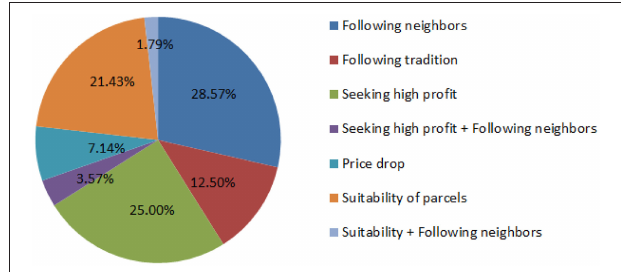
FIGURE 10 | Survey results about the main motivations behind land-use change in Binh Thanh Village, Thanh Phu district, Ben Tre province,